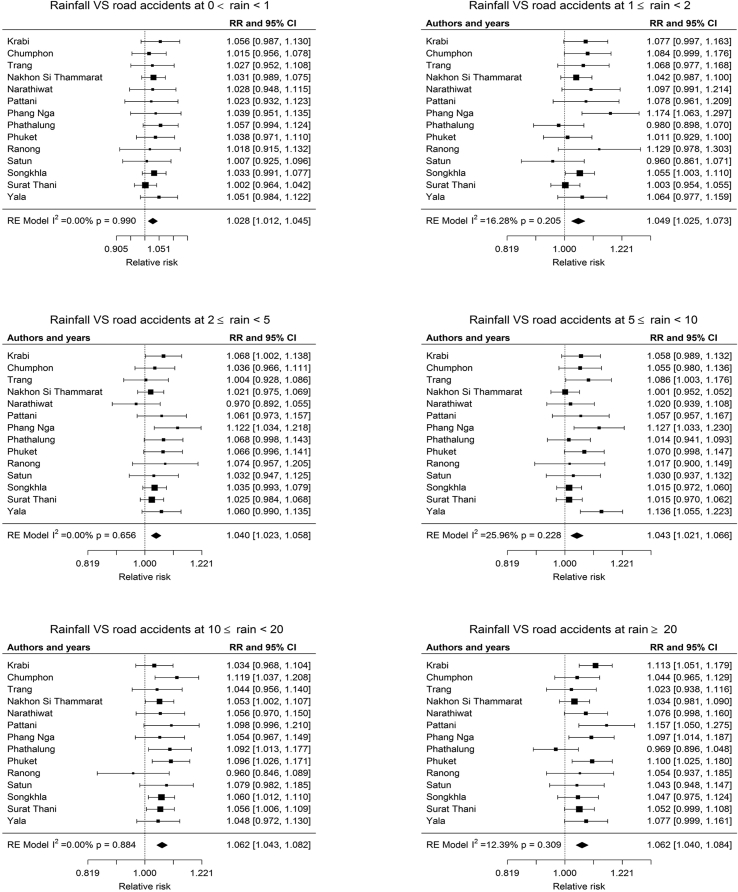
Forest plot for rainfall and road accidents at different rain volume (rain group) in the Southern provinces of Thailand.